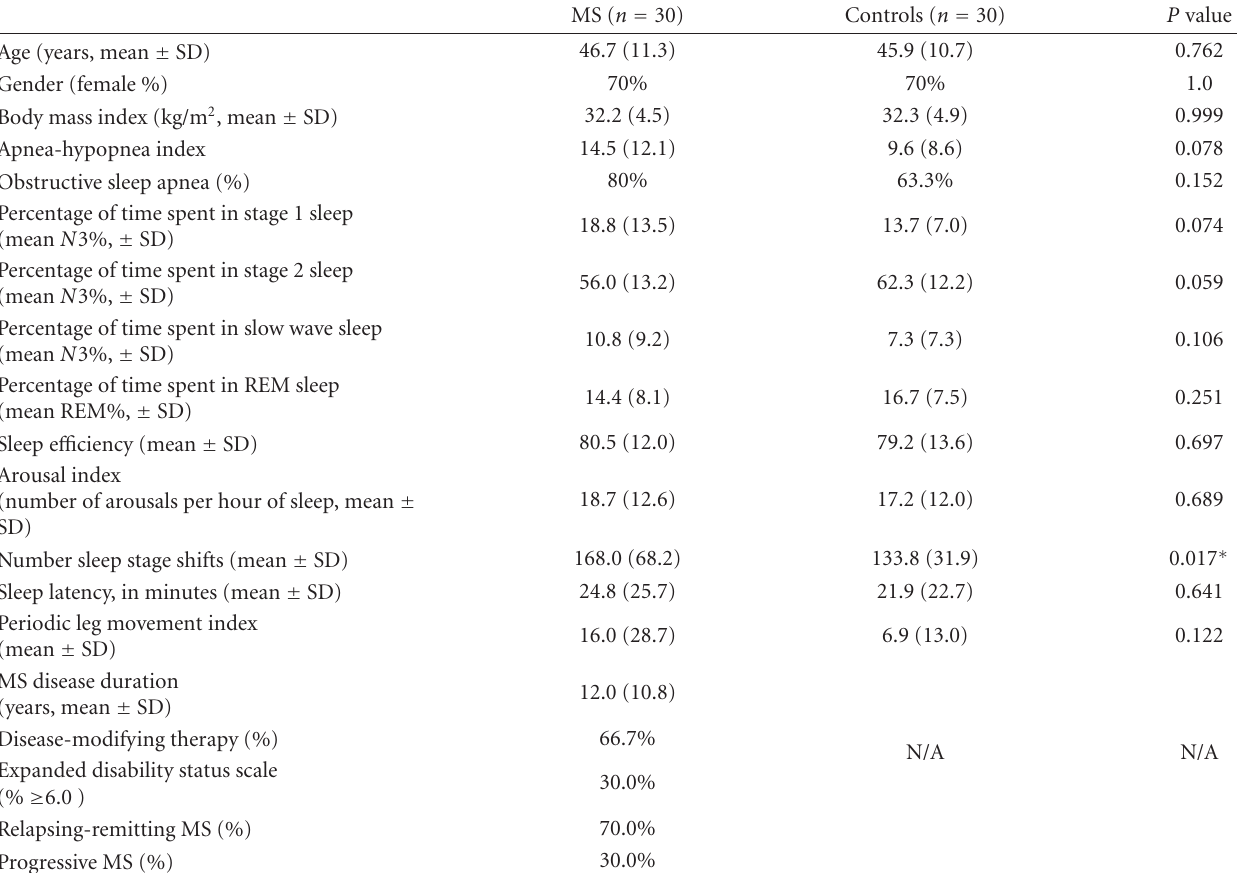
Table 1: Baseline characteristics, polysomnographic findings, and results of univariate analyses for MS patients compared to matched con- trols. ∗ P value < 0.05.